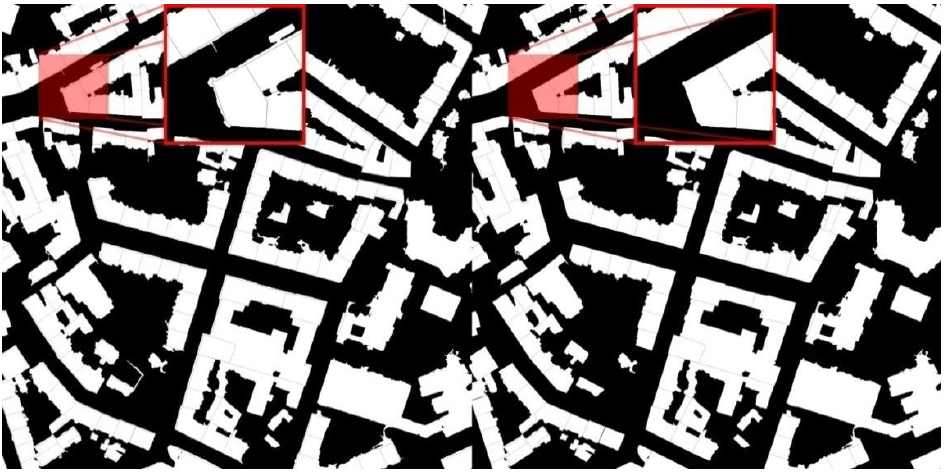
Figure 10. Overlay of segmented image and cadastre for one of the samples in Figure 9. Left is with the discrepancies due to roof eaves and facade detail, to the right is a manually cleaned-up